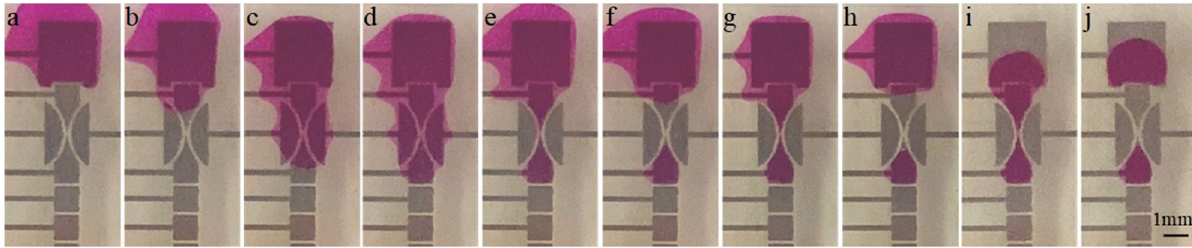
Figure 6: Series of video frames about droplet dispensing using the optimized electrodes scheme with the cutting electrodes radius R = 1.6 mm; ( a – f ) The fi rst droplet was generated; ( g and h ) The fi fth droplet was dispensed; ( i and j ) The tenth droplet was dispensed.